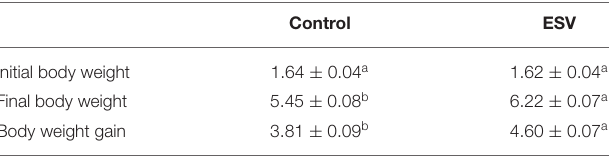
TABLE 3 | Evaluation of an experimental subunit vaccine (ESV) against enterotoxigenic E. coli (ETEC) on initial body weight, final body weight (day 26), and body weight gain of neonatal piglets.